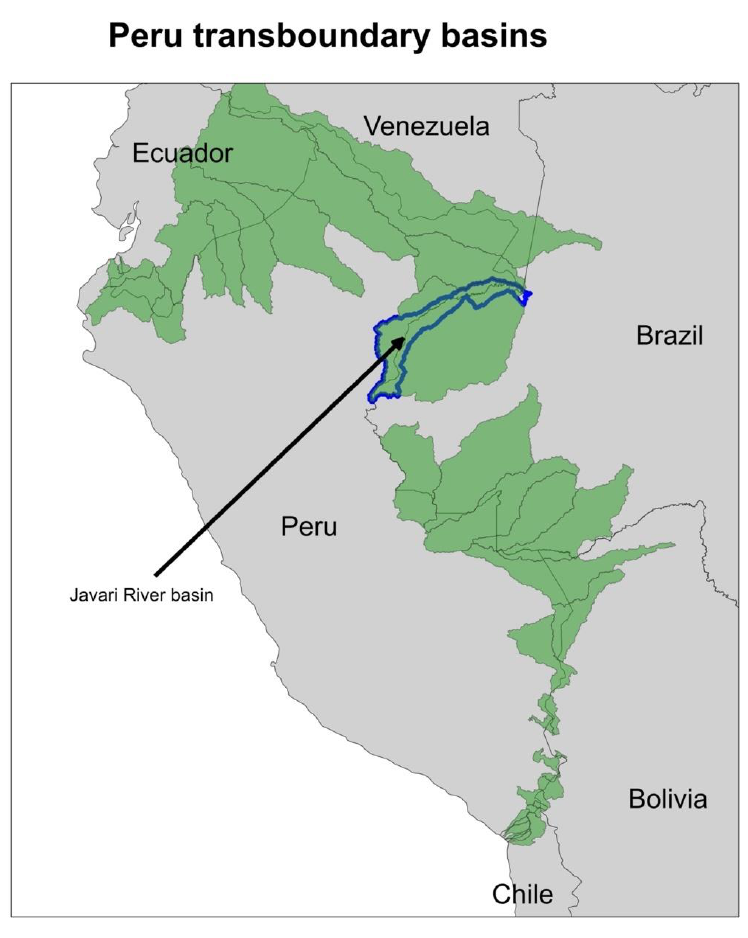
Figure 10. Peru's transboundary basins. In blue, lines that delimit the Javari River basin. Figure 10. Peru’s transboundary basins. In blue, lines that delimit the Javari River Additionally, it is worth mentioning the absence of complementary alphanumeric data. The name of the basin or its primary rive r’ s name is one of the factors to consider when determining transboundary basin delimitations. Data from Peru and Uruguay is well described, demonstrating the basin area in addition to these names; however, alpha- numeric data from Brazil has only one coding for each polygon (Figure 11).